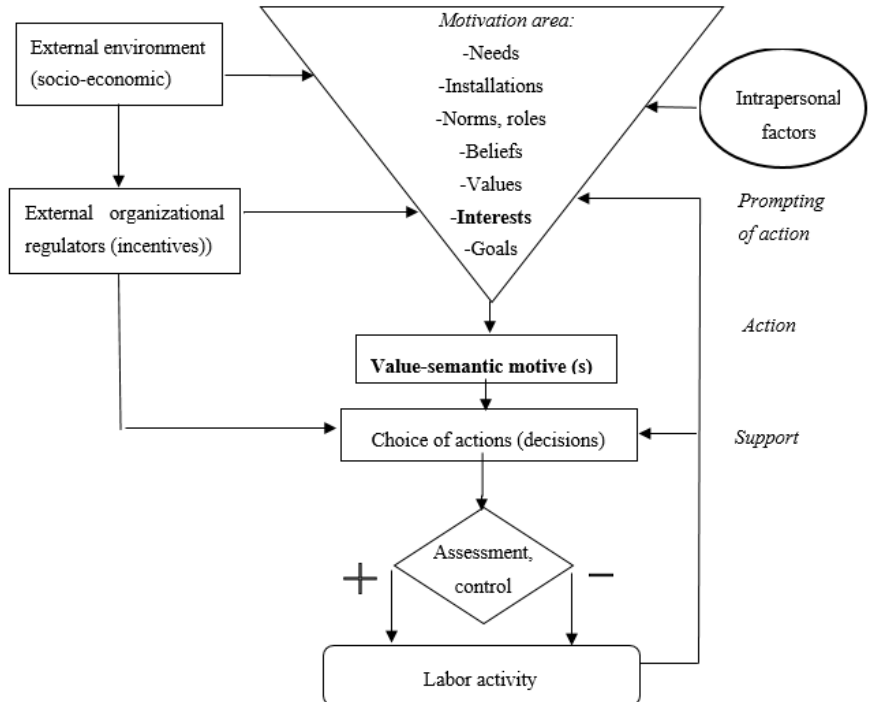
Figure 1. The mechanism of motivation for activity and place of interest.